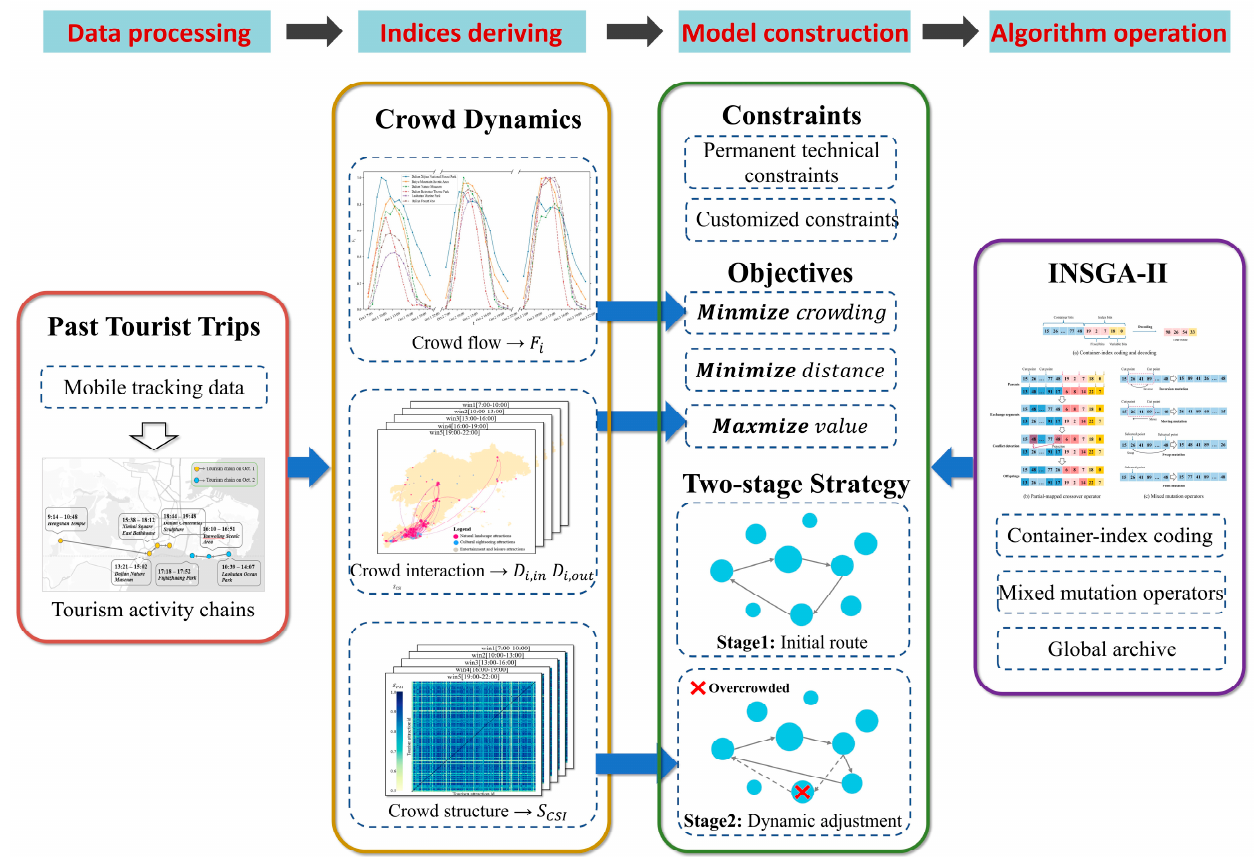
Figure 1. Information derivation and route recommendation strategies for TTDP-CD. The crowd flow, reflected by the time-varying crowd flow indicator 𝑭 𝒊 , is used to assist tourists in avoiding peak hours. The crowd interaction between attractions reveals the status of each attraction in the interaction network, which is reflected by the degree of nodes 𝑫 𝒊,𝒊𝒏 and 𝑫 𝒊,𝒐𝒖𝒕 and is used to determine the value of destinations. As the dynamic adjustment is activated, the attraction replacement scheme is determined by the similarity of the crowd structure 𝑺 𝑪𝑺𝑰